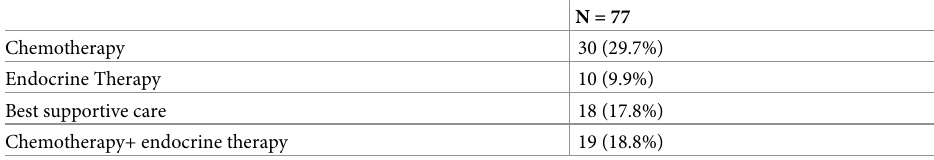
Table 4. Subsequent treatments after progression on CDK 4/6